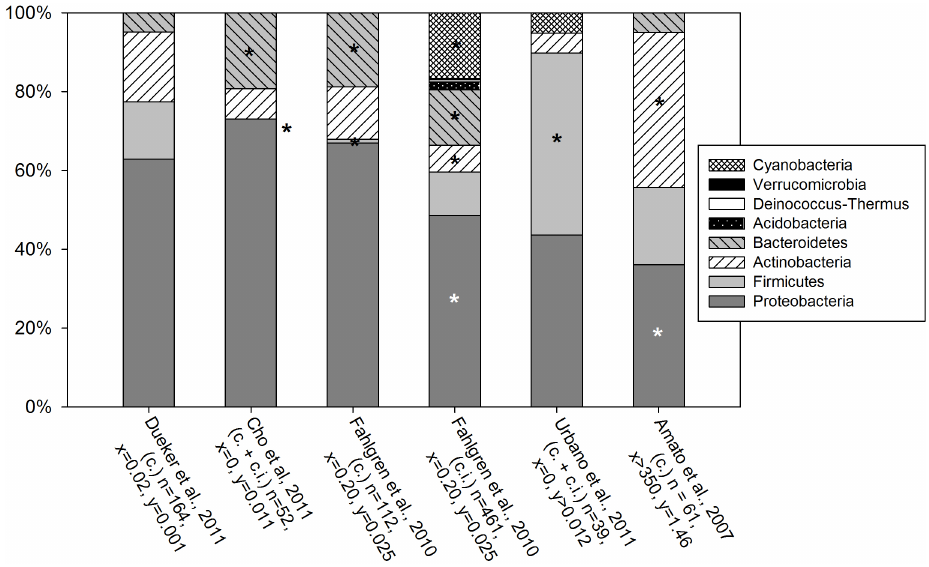
Fig. 3. Phylum-level classification of sequence libraries from this study’s data (coastal Maine, USA) and GenBank-published sequence libraries from marine/coastal/cloud studies using culture-based (c.) and/or culture-independent (c.i.) methods. Number of sequences ( n ), distance to shoreline (km) (x), and sampling height (km) (y) noted for each library. Classifications assigned using RDP’s Naive Bayesian rRNA Classifier (80% threshold) Version 2.2, March 2010. An asterisk (*) indicates significant differences in phylum-level community structure from this study as per RDP’s Library Compare Tool, p < 0 . 01. An asterisk outside a bar indicates that the library is significantly missing a phylum (asterisk placed at same height as this study’s phylum breakdown).